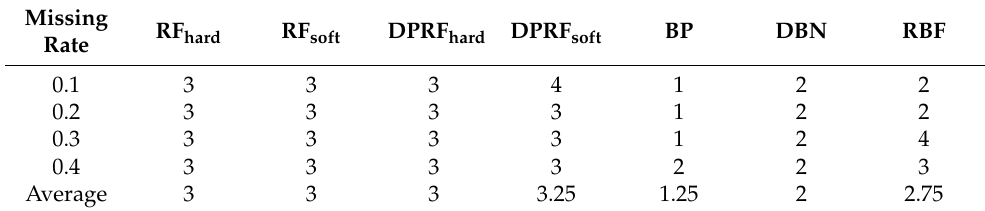
Table 4. Robustness scores for the seven